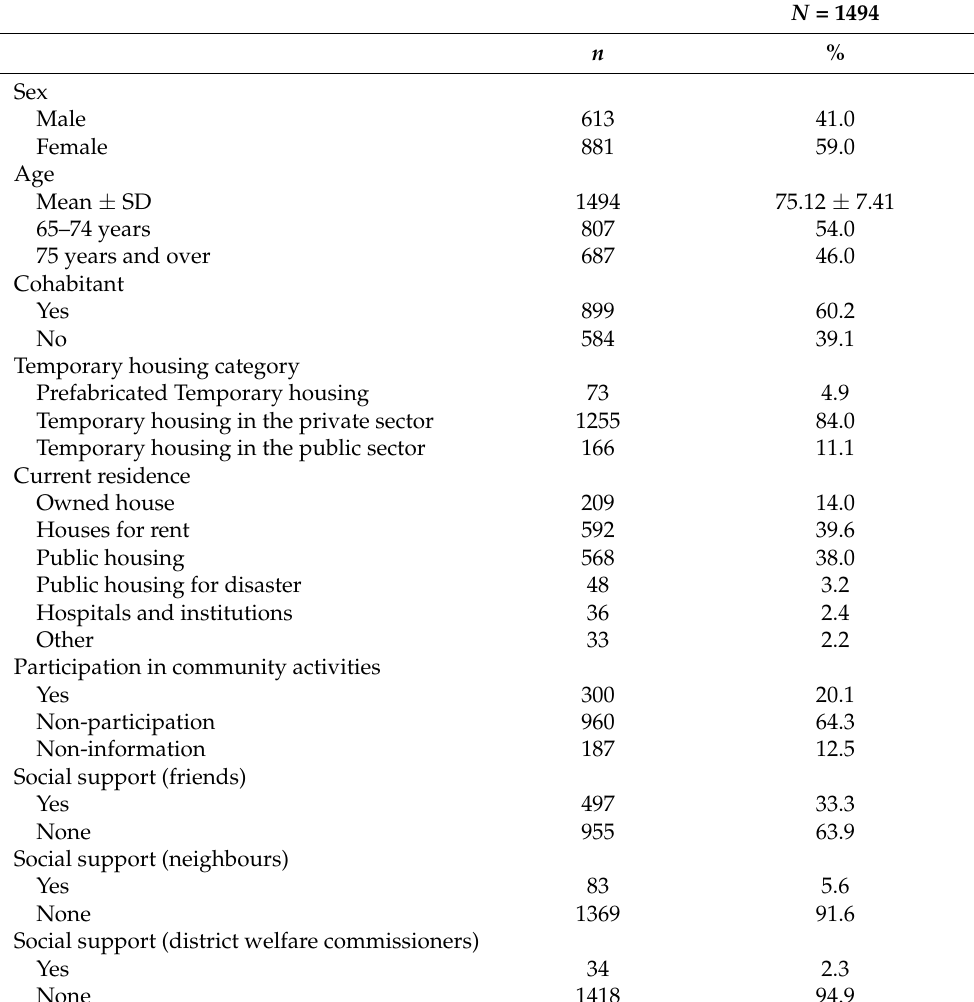
Table 1. Participants’